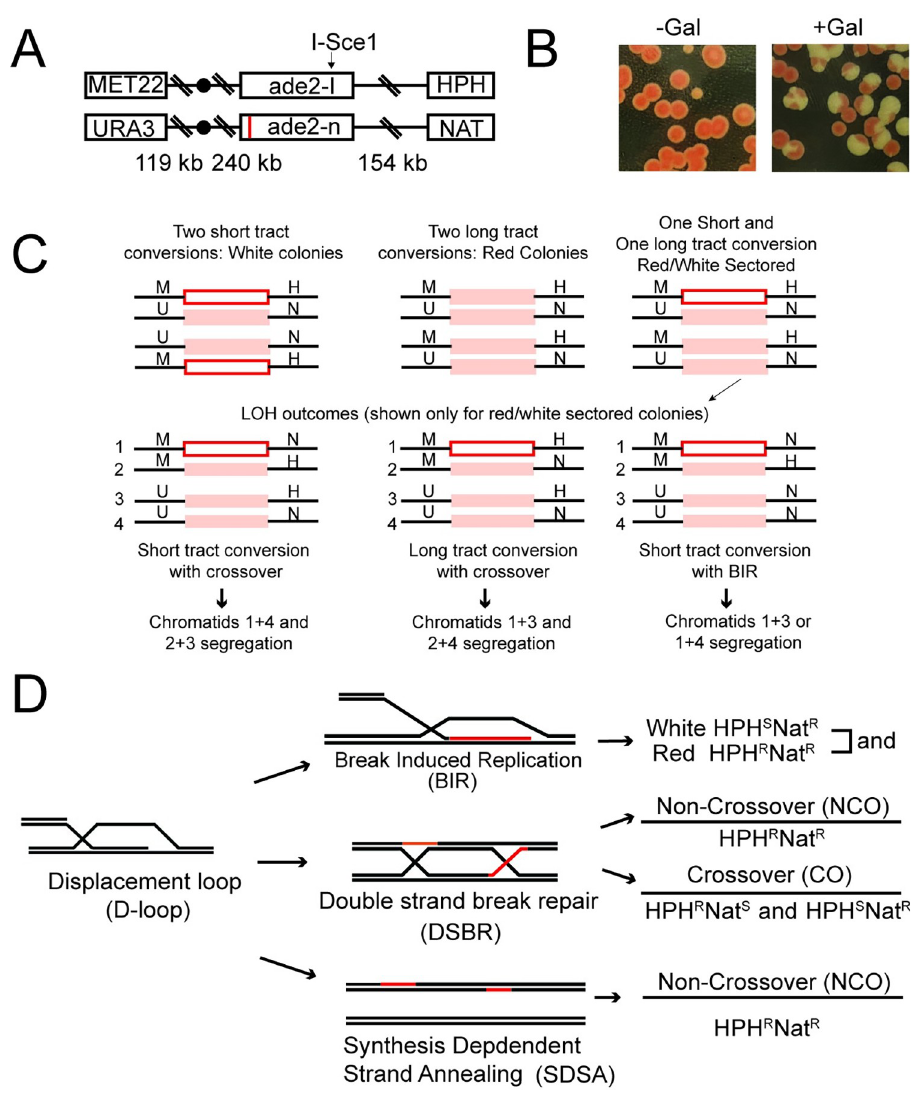
Fig 1. Analysis of RDH54 in post gene conversion recombination. (A). Schematic diagram illustrating assay used to monitor recombination between homologous chromosomes during a double strand DNA break. The reporter is located on chromosome XV and only one homolog has an active I-SceI site. The inactivating mutations ade2-n is shown by a red line in the diagram. If Short tract gene conversion occurs (STGC) this mutation is lost and the ADE2 becomes active. (B). Yeast colonies plated after ± induction of I-SceI using galactose. (C). Schematic diagram illustrating the potential outcomes for DNA repair via homologous recombination. In the first step gene conversion can occur through long tract or short tract DNA repair. Following cellular division, non-crossover, crossover, and break induced replication (non-reciprocal exchange) outcomes can be determined for each event. (D). Cartoon illustration of HR outcomes that can be determined from this assay. The red lines indicate DNA